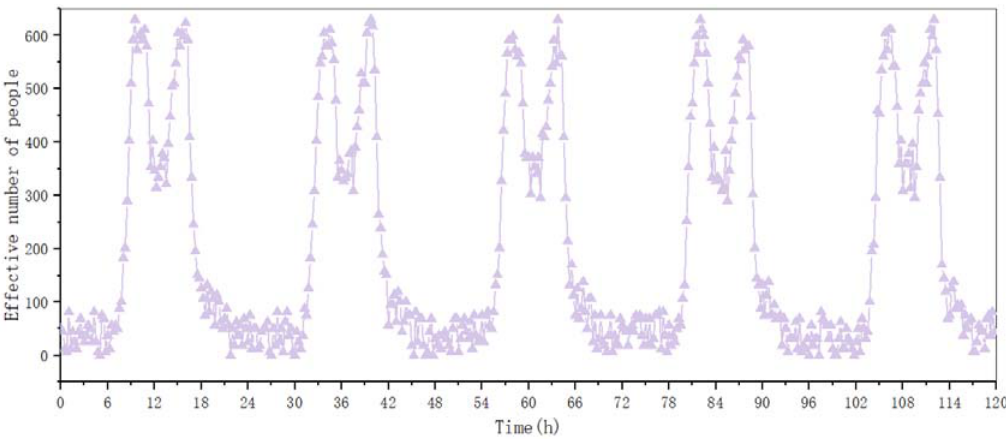
Figure 6. Distribution of effective number of people on working days in a week.